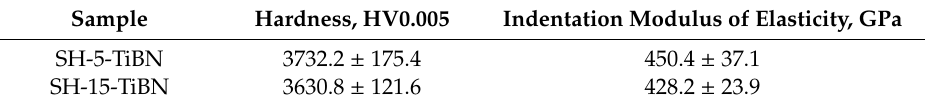
Figure 21. The force-indentation depth curves of coated sample SH-15-TiBN. Table 11. Microhardness and Young’s modulus of coating.